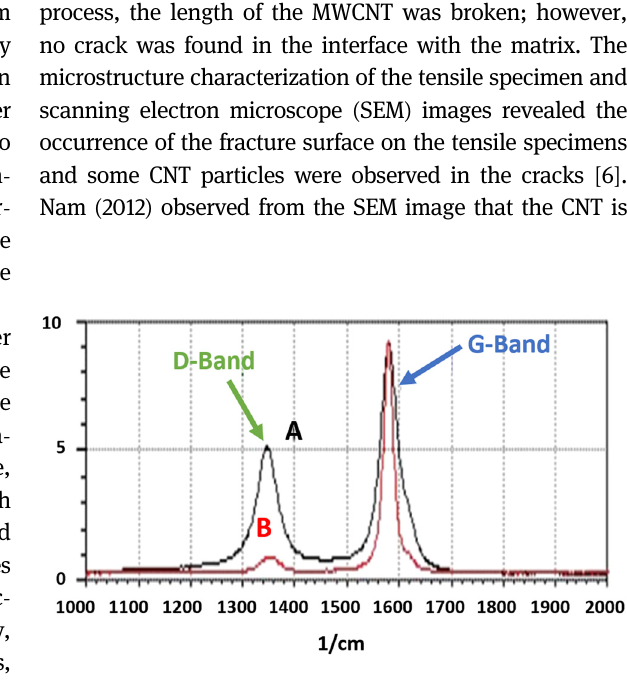
Figure 1: General Raman spectra patterns of MWCNTs [ 11,12 ]